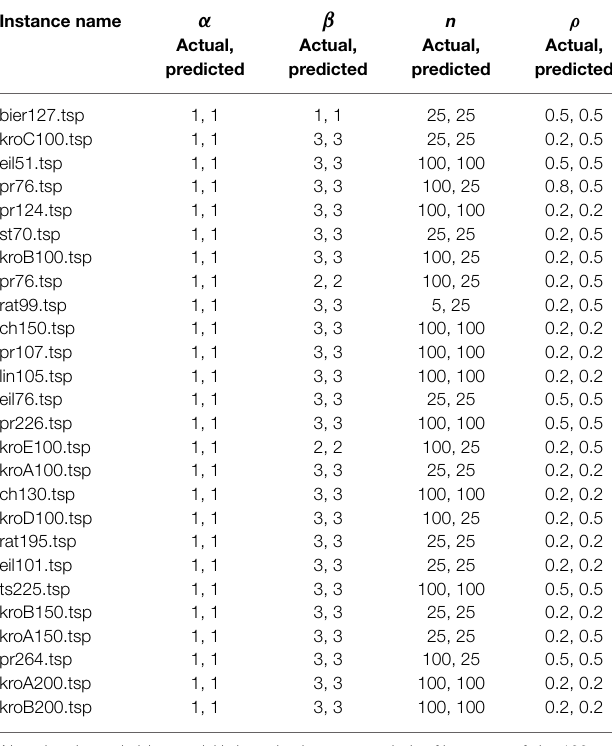
TABLE 6 | Predicted and actual parameter settings ( (cid:11) , (cid:12) , n , and (cid:26) ) for 26 TSPLIB instances of size in range 51–264 from the prediction model 2b